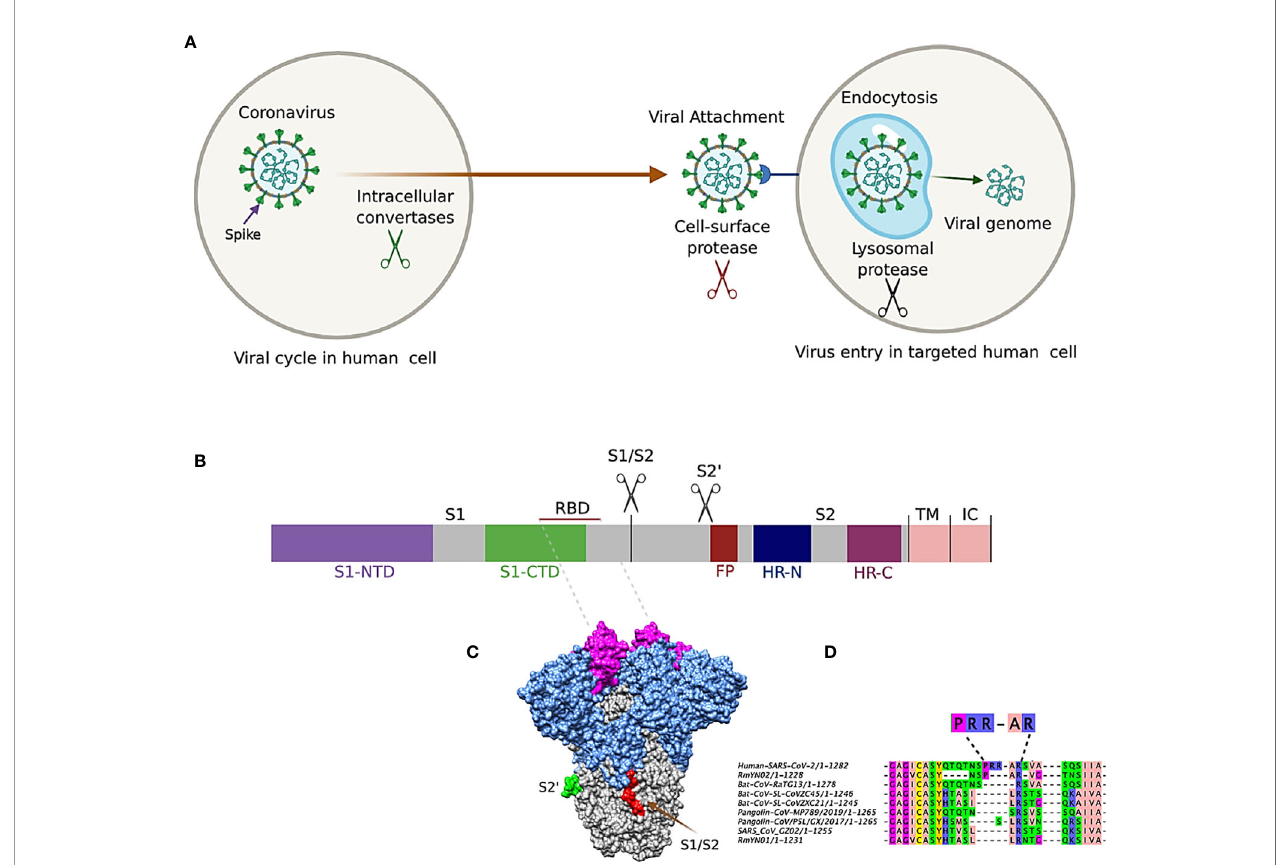
FIGURE 4 | (A) Entry of coronavirus into host cell and the role of protease cleavage in viral replication. (B) Schematic description of coronavirus Spike. S1-NTD: N- terminal domain; S1-CTD: C-terminal domain; RBD: Receptor Binding Domain; S1/S2: furin/multibasic cleavage site; S2: proteolysis site; FP (fusion peptide); Heptad Repeat Regions N and C (HR-N and HR-C); Transmembrane Anchor (TM); and the Intracellular Tail (IC). S1, receptor-binding subunit; S2, membrane fusion subunit; TM, transmembrane anchor; IC, intracellular tail. (C) 3D representation of CoVs Spike with RBD, furin S1/S2, and S2 cleavage domains. (D) Sequence comparison of the SARS-CoV-2 and other SARS-CoV Spike proteins on the region at the S1/S2 boundary, indicating the RRAR motif for